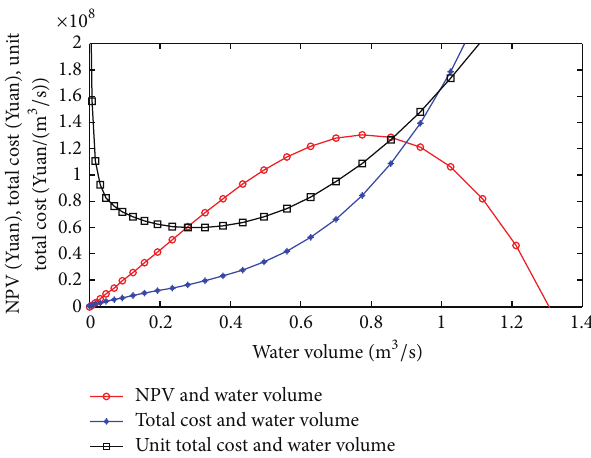
Figure 2: Functional relationships between water volume and NPV, total cost, and unit total